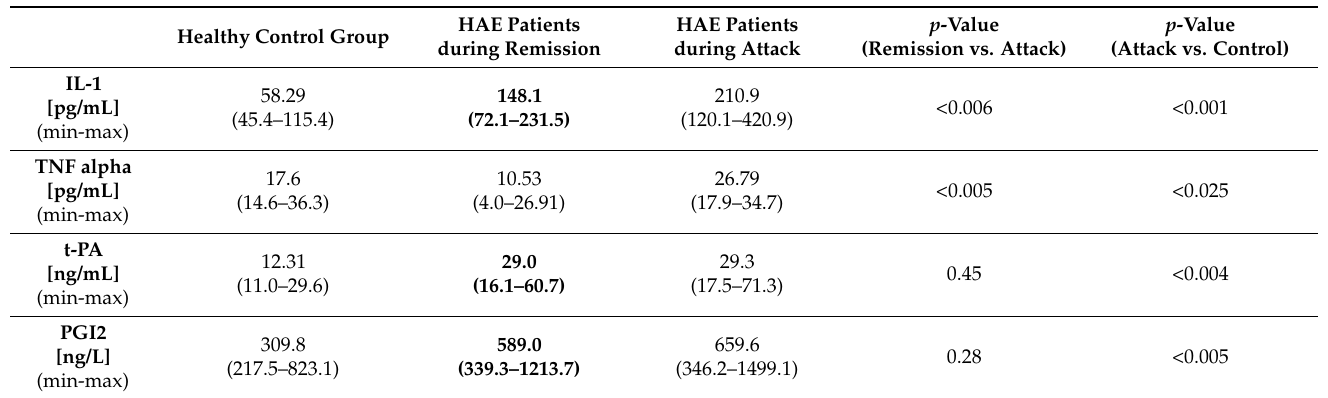
Table 3. Correlation between disease-specific markers and HAE